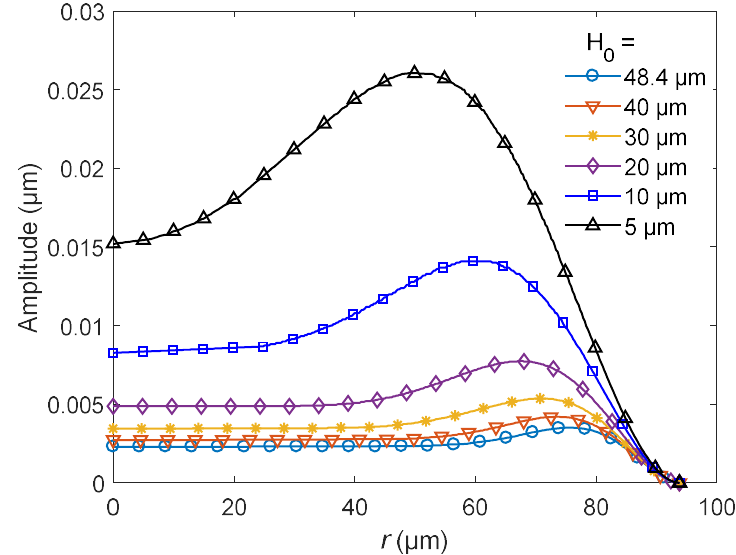
Figure 7. The amplitude distribution of the bionic structure for different heights H 0 . Table 4. The relative distance of the maximum amplitude for di ff erent heights H 0